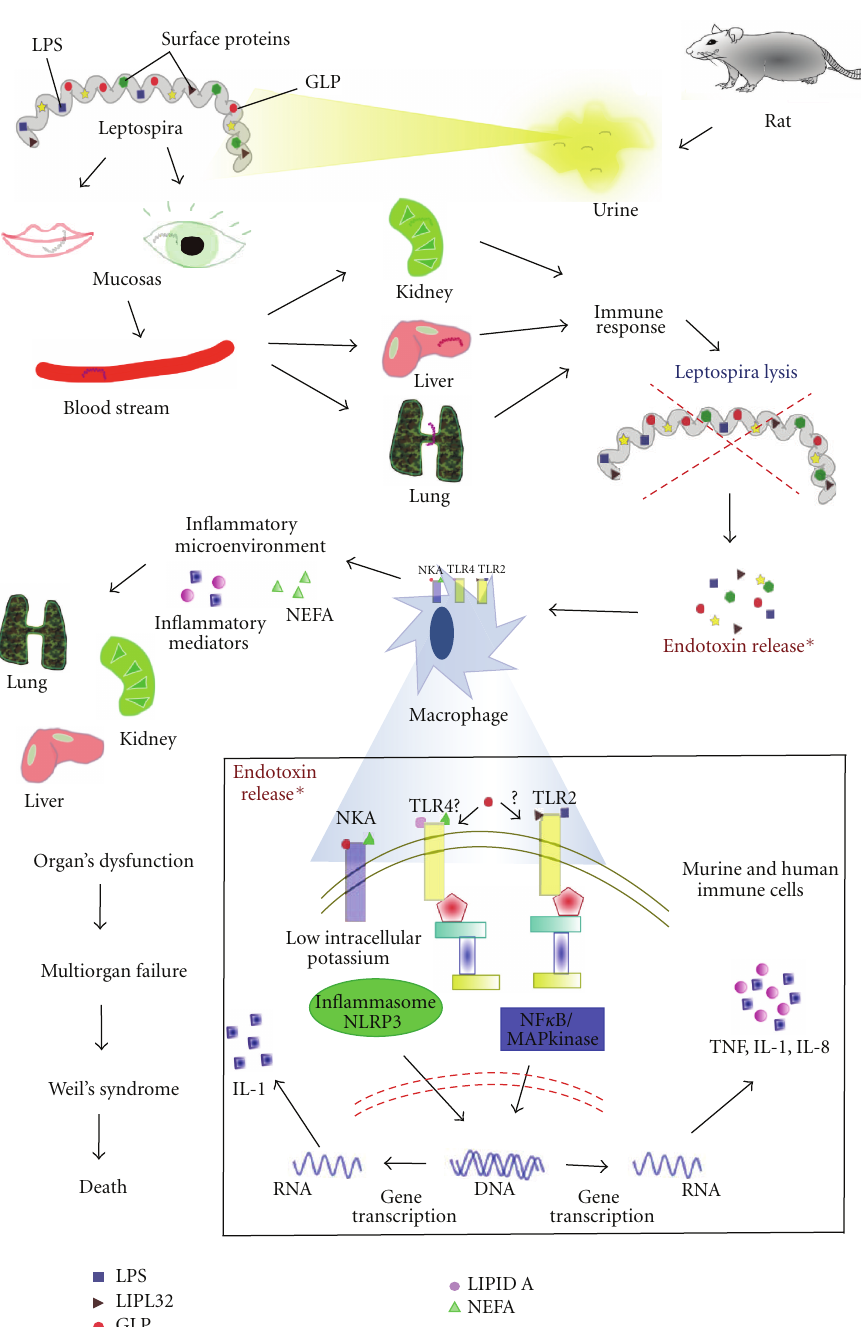
Figure 1: Severe leptospirosis: from the infection to immunological target. Due to their mobility, leptospiras are able to penetrate mucosal tissues and injured skin. Transported by the blood stream, they reach target organs, mainly the kidney and liver. The host immune response kills the bacteria, promoting endotoxin release. The innate immune system of both human and mouse recognizes endotoxins through specific receptors. This immune cell response is mediated by Toll-like receptors and Na/K-ATPase, which sense antigen molecules and trigger intracellular signaling pathways driving the translocation of transcription factors, leading to increased inflammatory mediator production. This scenario creates an inflammatory microenvironment that can lead to organ dysfunction. Another important observation in this disease is the increased NEFA levels in the systemic circulation (mainly oleic acid). Augmented albumin unbound-NEFA may play an important role in multiorgan dysfunction by acting on endothelium and immune cells. TLR2: Toll-like receptor 2; TLR4: Toll-like receptor 4; NKA: Na/K-ATPase; NF- κ B: nuclear factor kappa-light-chain-enhancer of activated B cells; NEFA: nonesterified fatty acid; LIPL32: major outer membrane leptospiral lipoprotein; GLP: leptospiral